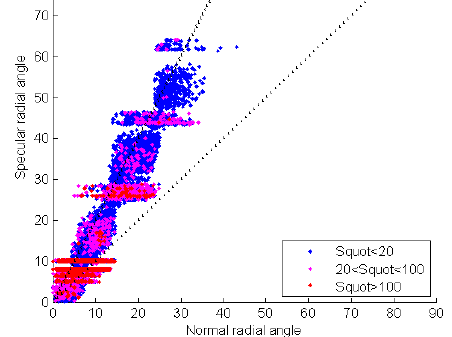
Figure 14. Specular vs normal angles for 10,000 pixels, classified by specular quotient value.